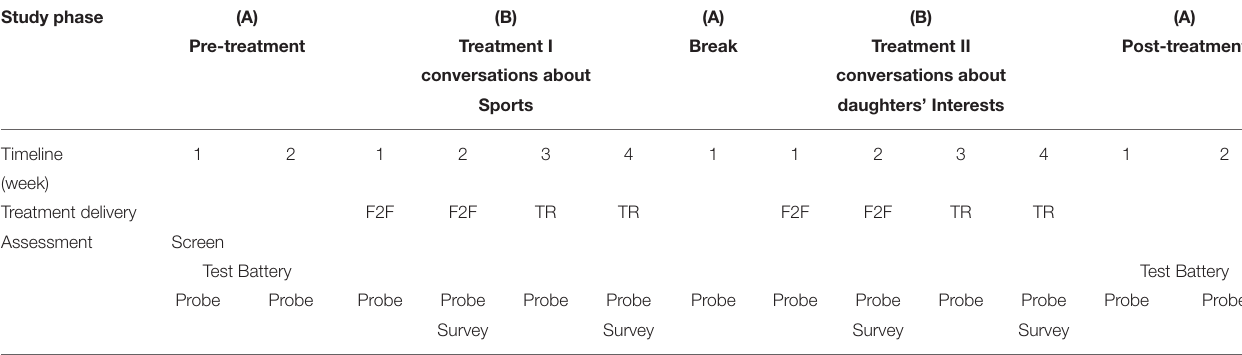
TABLE 1 | Timeline and study design showing assessment schedule in relation to treatment phase. Study